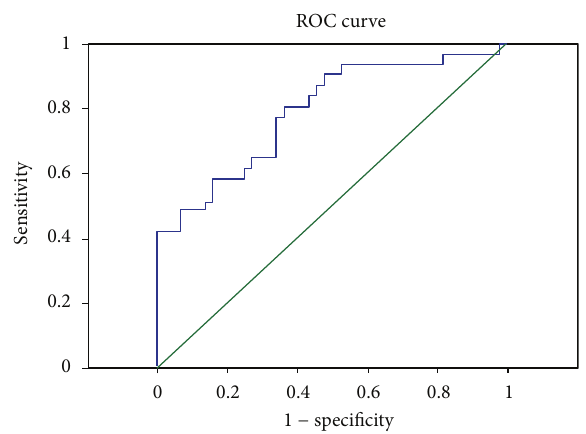
Figure 1: ROC curves of the sensitivity and specificity of sTREM- 1 to discriminate between myocardial dysfunction and non- myocardial dysfunction in patients with severe sepsis.